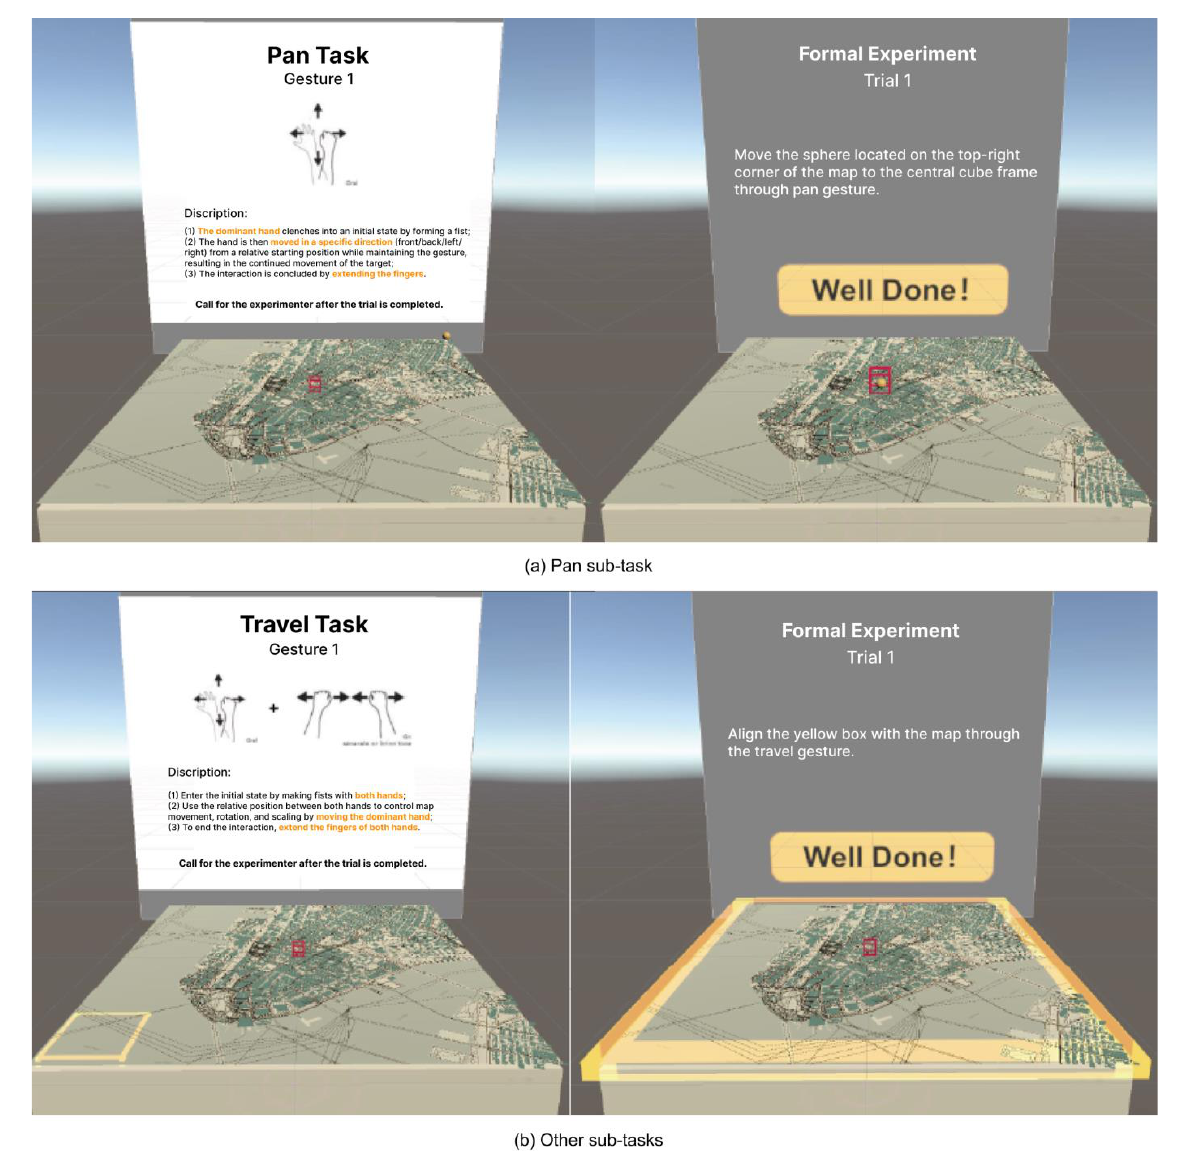
Figure 6. The virtual scene of experiment 2.